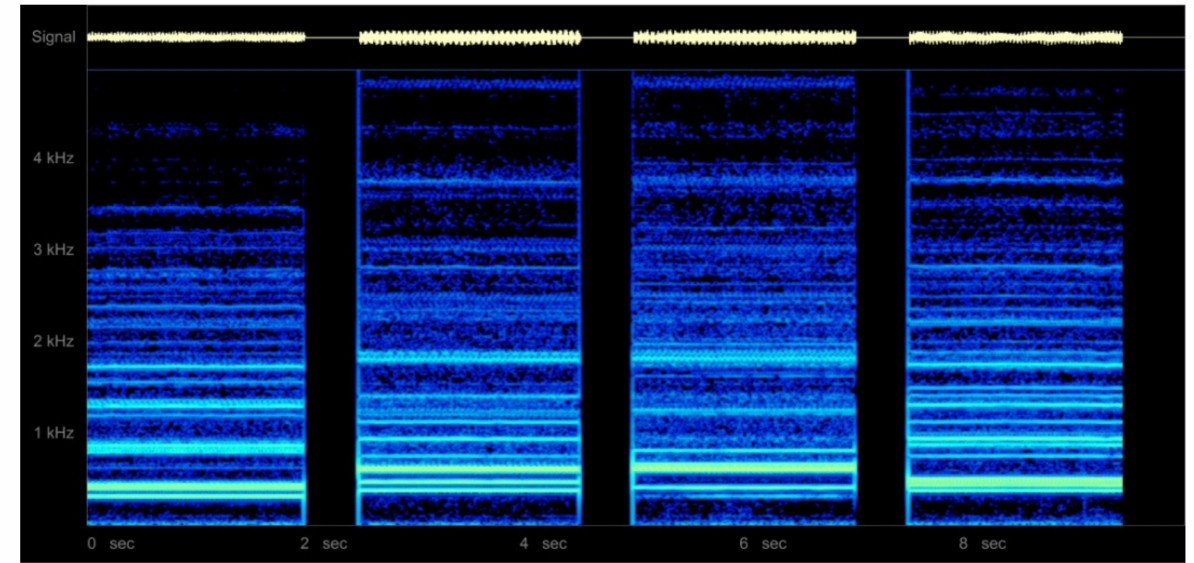
Figure 26. Spectrogram of quadruple flute experimental model “Anahuacalli 1”, low blowing pressure, fingering positions from left to right: all fingerholes stopped; all fingerholes open; holes of pipes A–B open, pipes C–D stopped; holes of pipes A–B stopped, pipes C–D open (Sample